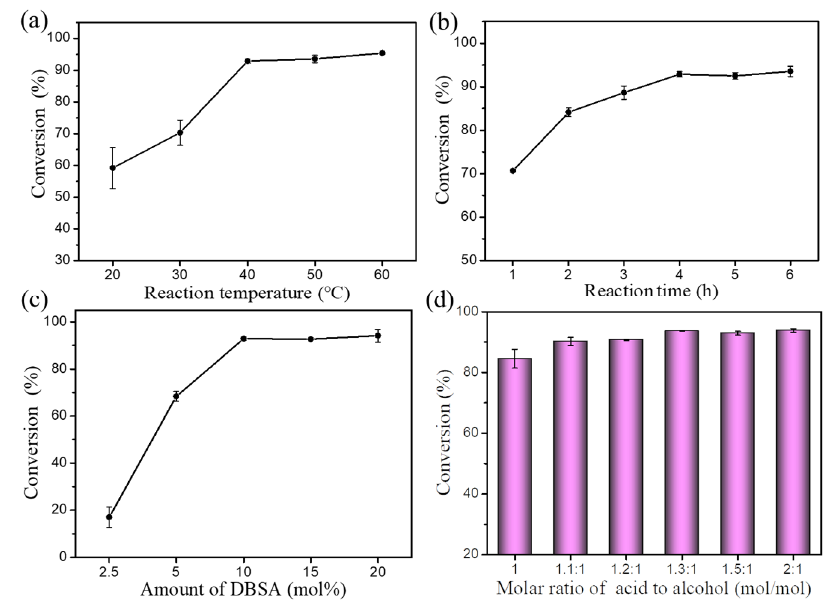
Figure 3. Effects of ( a ) reaction temperature, ( b ) reaction time, ( c ) amount of DBSA, and ( d ) molar ratio of oleic acid to alcohol on esterification. Reaction conditions: ( a ) a molar ratio of 1.5:1 oleic acid to alcohol, 10 mol% DBSA, and a reaction time of 4 h; ( b ) a reaction temperature of 40 °C, a molar ratio of 1.5:1 oleic acid to alcohol, and 10 mol% DBSA; ( c ) a reaction temperature of 40 °C, a molar ratio of 1.5:1 oleic acid to alcohol, and a reaction time of 4 h; ( d ) a reaction temperature of 40 °C, a reaction time of 4 h, and 10 mol% DBSA.